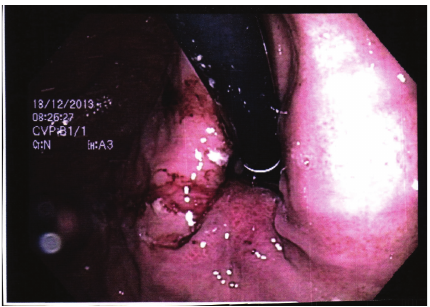
Figure 1: Polypoid mass in the distal oesophagus.